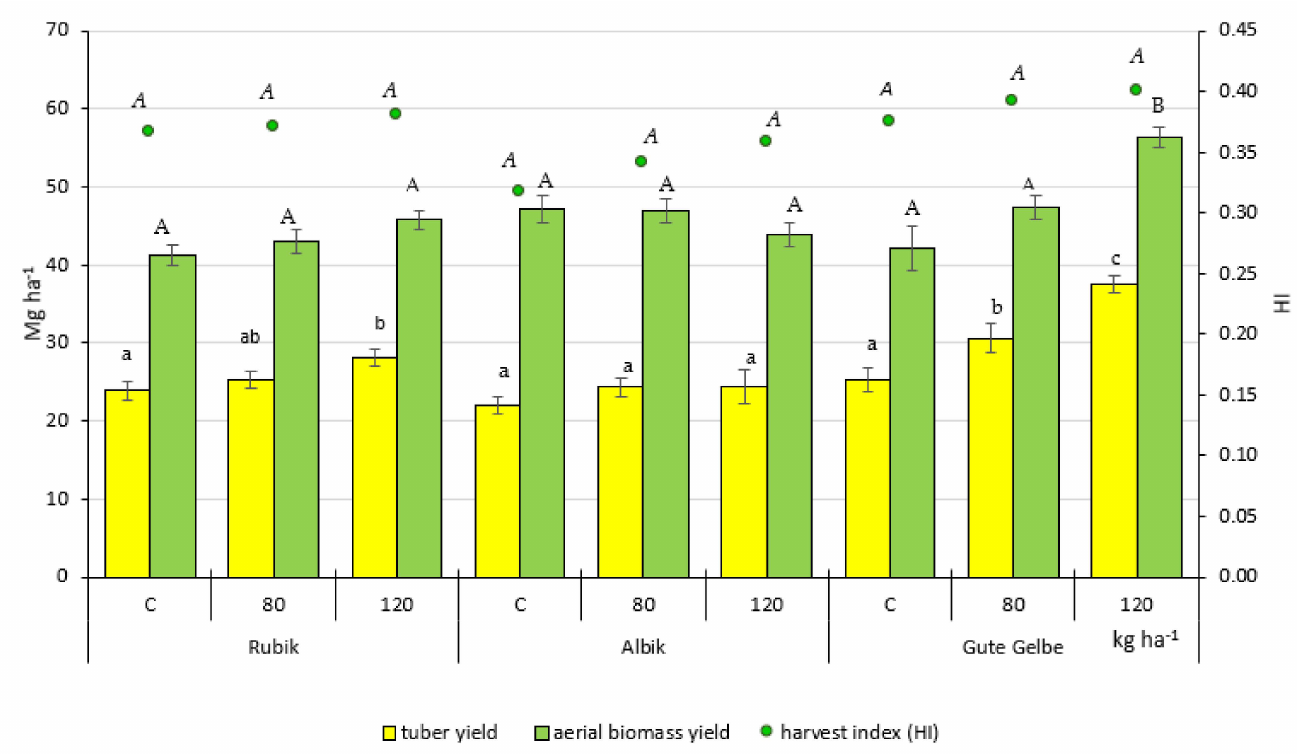
Figure 2. The effect of the nitrogen fertilizer rate and cultivar on Jerusalem artichoke yields and harvest index (HI) (3-year average ± SE) (explanations: SE—standard error; C—control, lower case letters for tuber yield, upper case letters for aerial biomass yield and italicized upper-case letters for HI; bars followed by the same letters do not differ significantly at p <